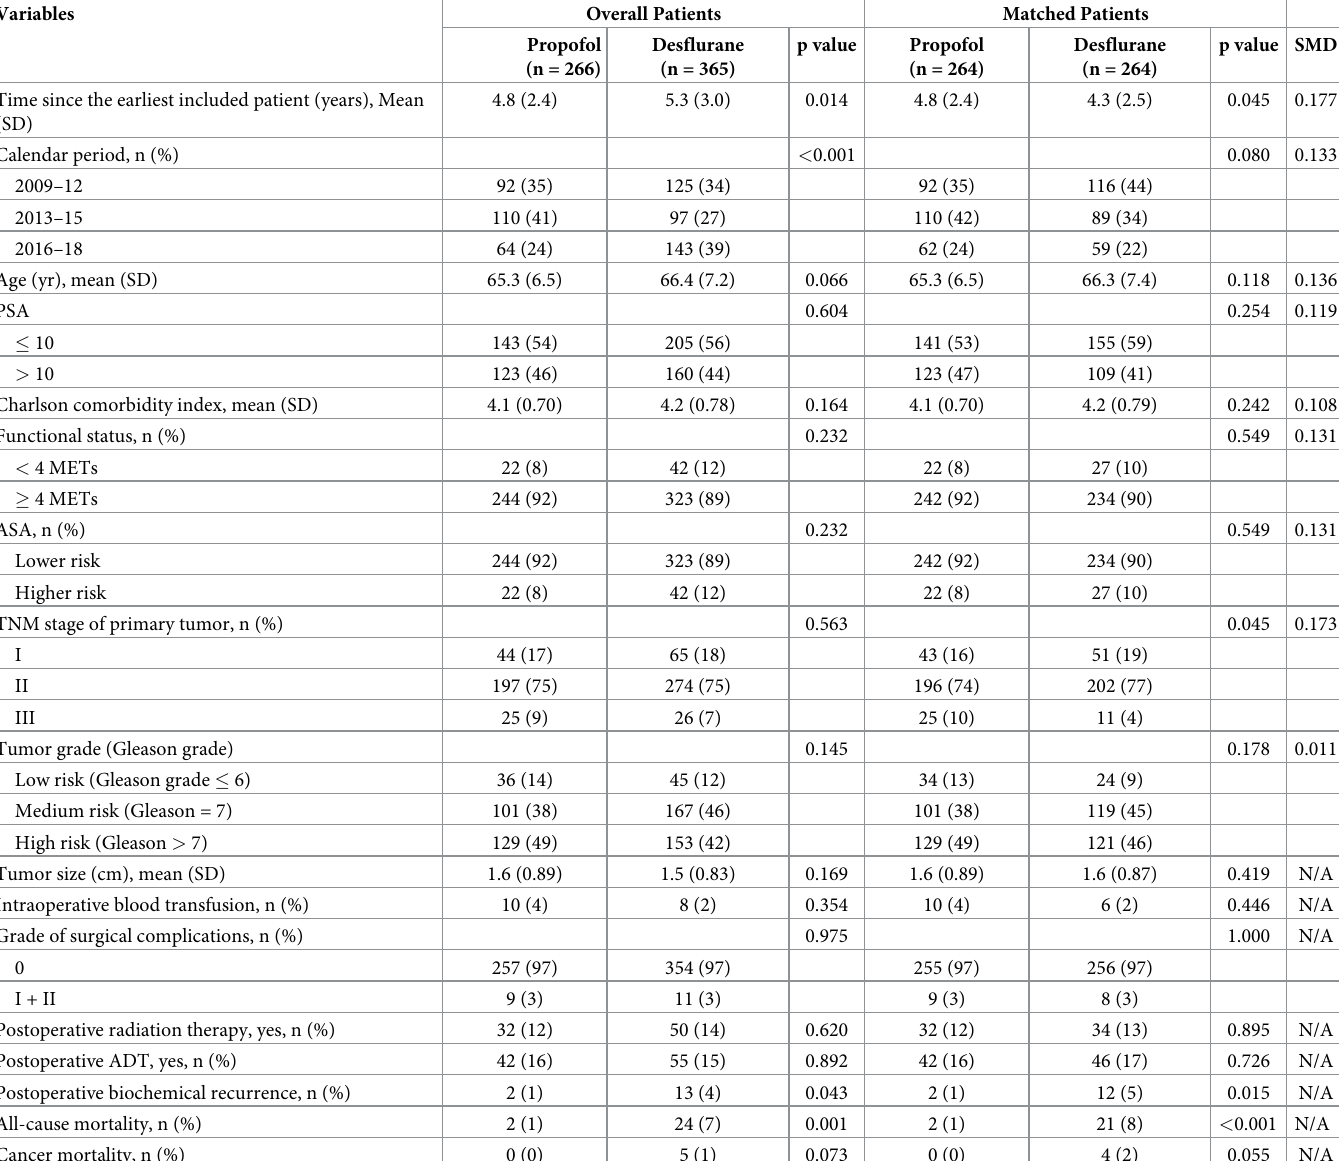
Table 1. Patients’ and treatment characteristics for overall group and matched group after propensity